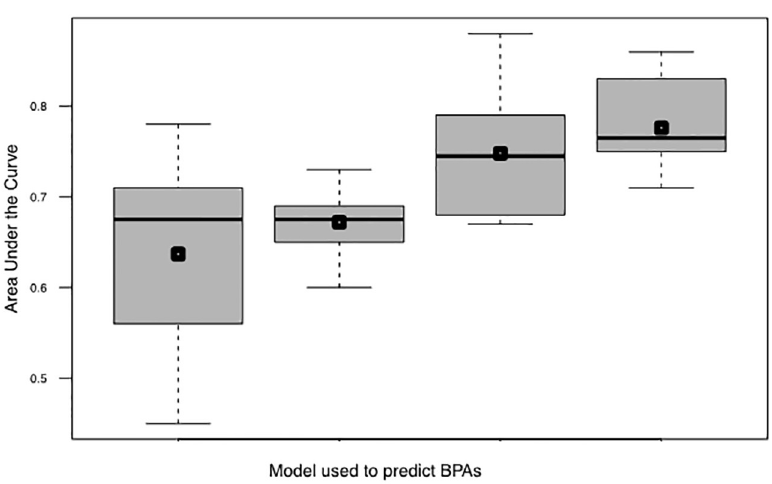
Fig 3. Comparison of how the pre-processing of the BPAD200 dataset impacts area under the curve (AUC) values obtained in reverse vaccinology (RV). Boxplots of AUC values were obtained by leave tenth out cross validation (LTOCV) of logistic regression classifiers predicting bacterial protective antigens (BPA) or non-BPAs from the curated dataset of BPAD200. From left to right; the raw dataset, the raw dataset scaled between -1 and 1 for each feature, using ten features scaled between -1 and 1 selected using GBFE with a support vector machine classifier as detailed in Heinson et al[16], using 10 features scaled between -1 and 1 selected using greedy backward feature elimination (GBFE) with a logistic regression